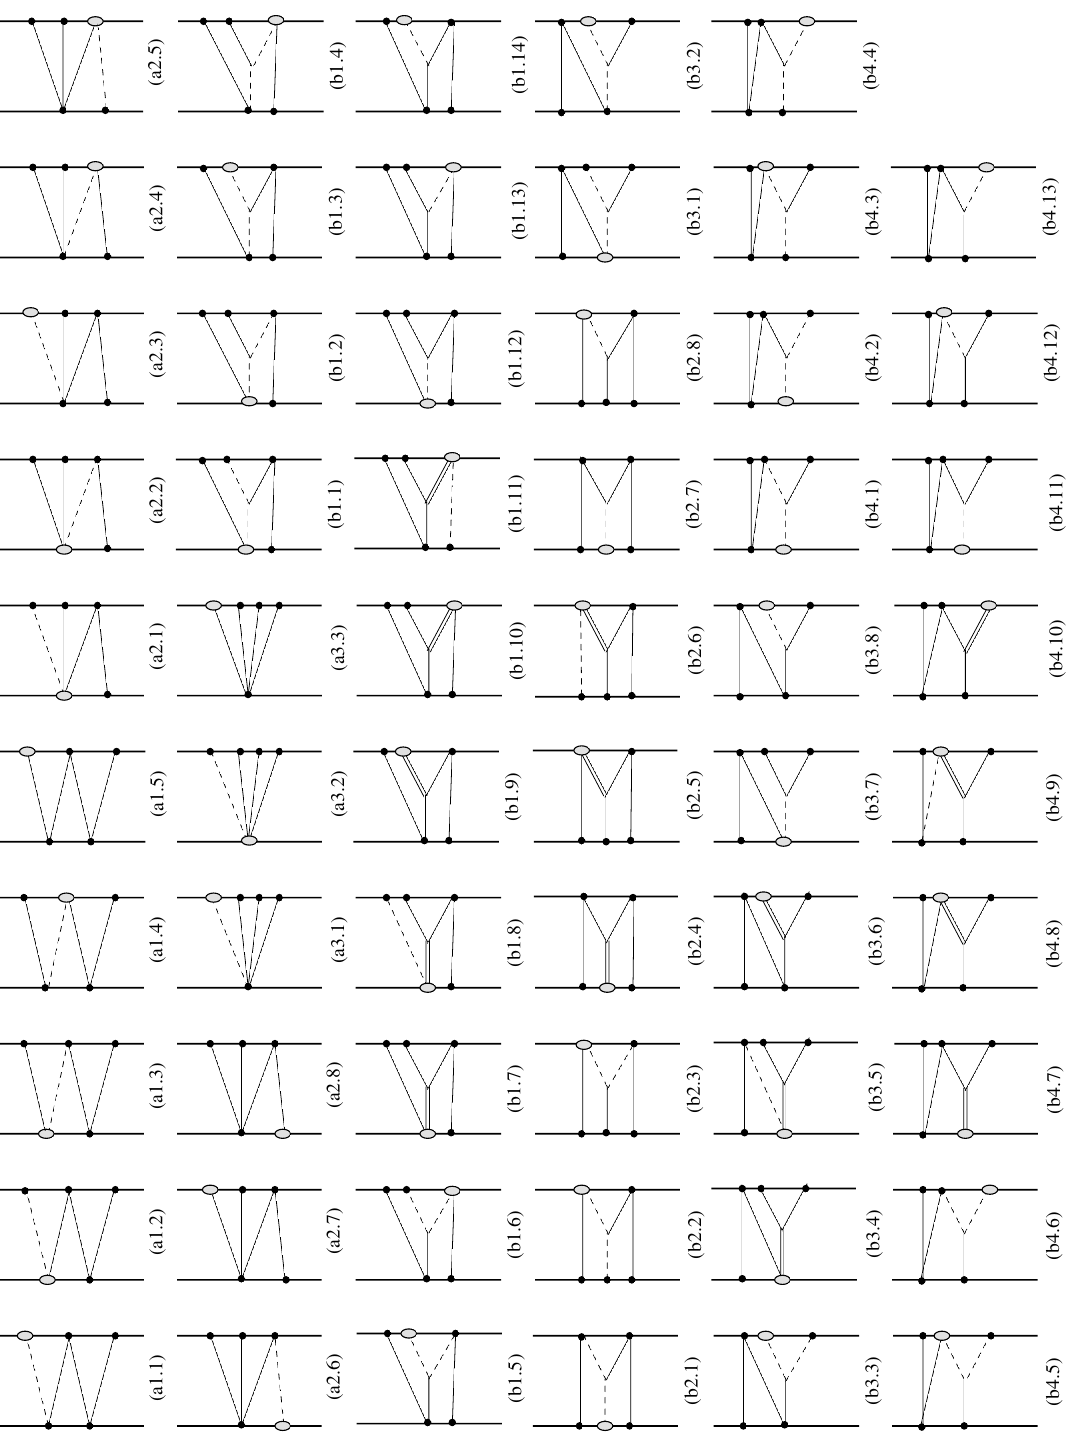
Figure 5 . Feynman graphs which contribute to the N 3 LO spin-orbit coupling at G 4 . This figure contains all graphs with topologies (a) and (b1)-(b4) of figure 4. All of the graphs presented in this figure and the following ones should be accompanied by their ‘mirror’ graphs, in which the worldline labels are exchanged, i.e. 1 ↔ 2